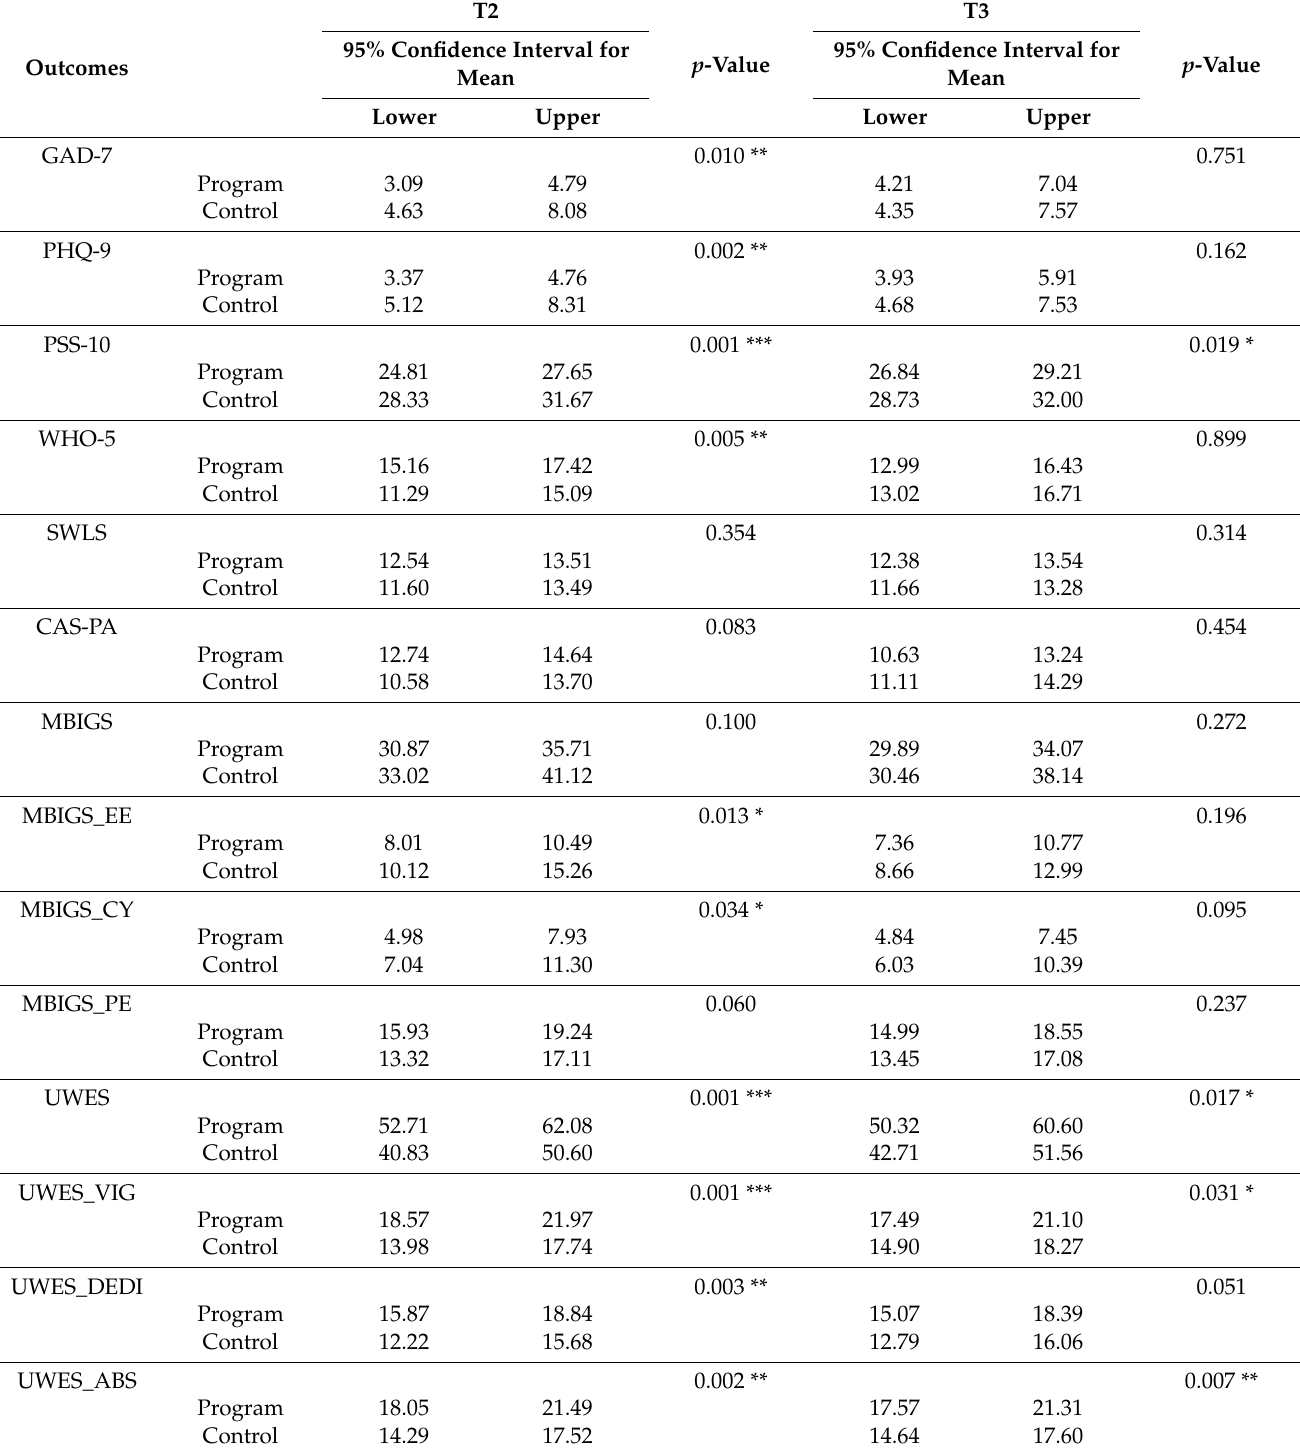
Table 4. One-way ANOVA results for comparing all outcomes among groups at T2 and